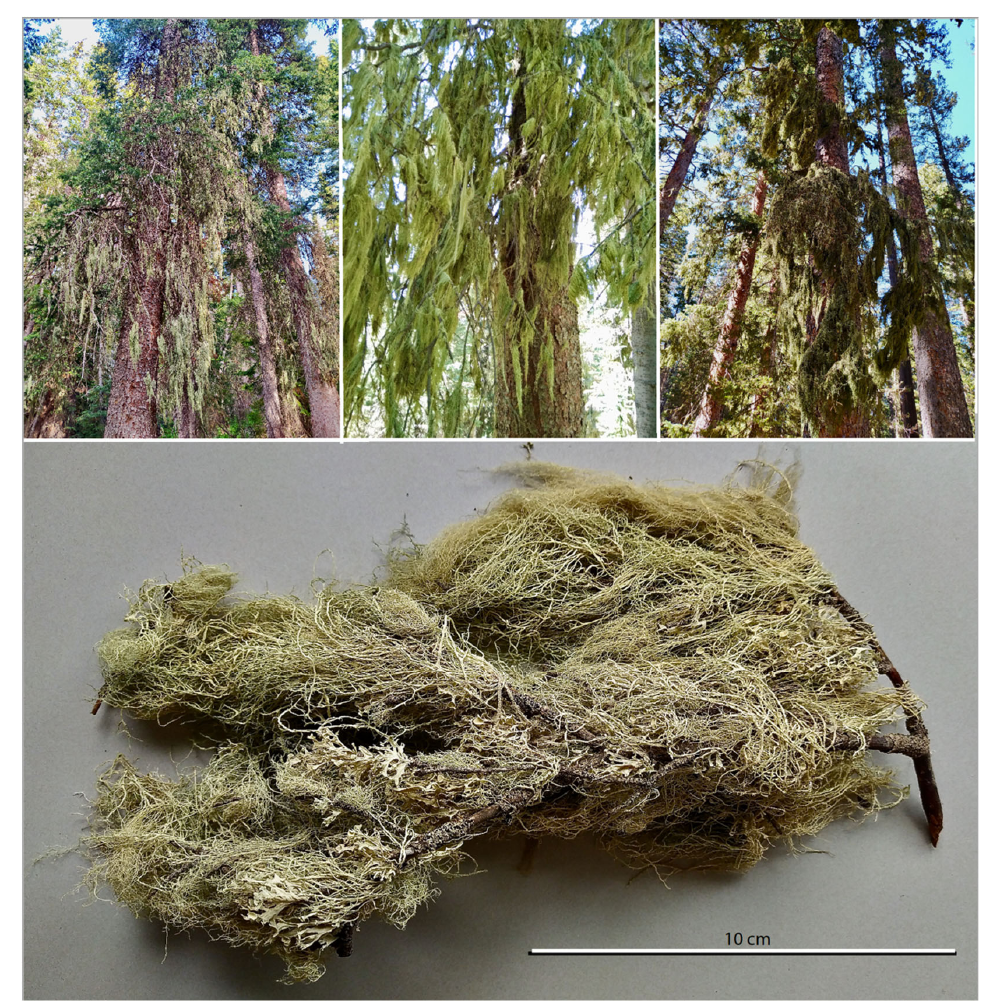
Figure 2. Lichen ‐ draped conifer sites in the La Sal Mountains. The top row includes photos from site ‘Geyser Pass 1 ′ , ‘Geyser Pass 2 ′ , and ‘Medicine Lake’ ( left to right ). The bottom panel depicts a typical lichen ‐ covered conifer branch sampled for DNA metabarcoding. Fruticose lichens included Evernia divaricata , Ramalina sinensis , and various Usnea species. Inconspicuous crustose lichens co ‐ occurred tightly appressed to bark.